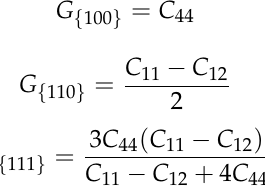
Figure 8. Calculated CDD in the (110) plane for ( a ) pure, ( b ) Re-substituted, ( c ) Ti-substituted, ( d ) Pt-substituted and ( e ) Tc-substituted L1 2 Co 3 Nb, respectively. From Figure 8a, it can be seen that the transferred electrons of pure γ′ -Co 3 Nb are mainly distributed between the Co atom and Nb atoms in the (110) plane, which indicates that they form a covalent-like bond. In the case of Re substitution (Figure 8b), transferred electrons homogeneously assembles around the Re atoms, forming a ring-shaped valence bond. This weakens the anisotropy of the (110) plane, and results in an increase in shear